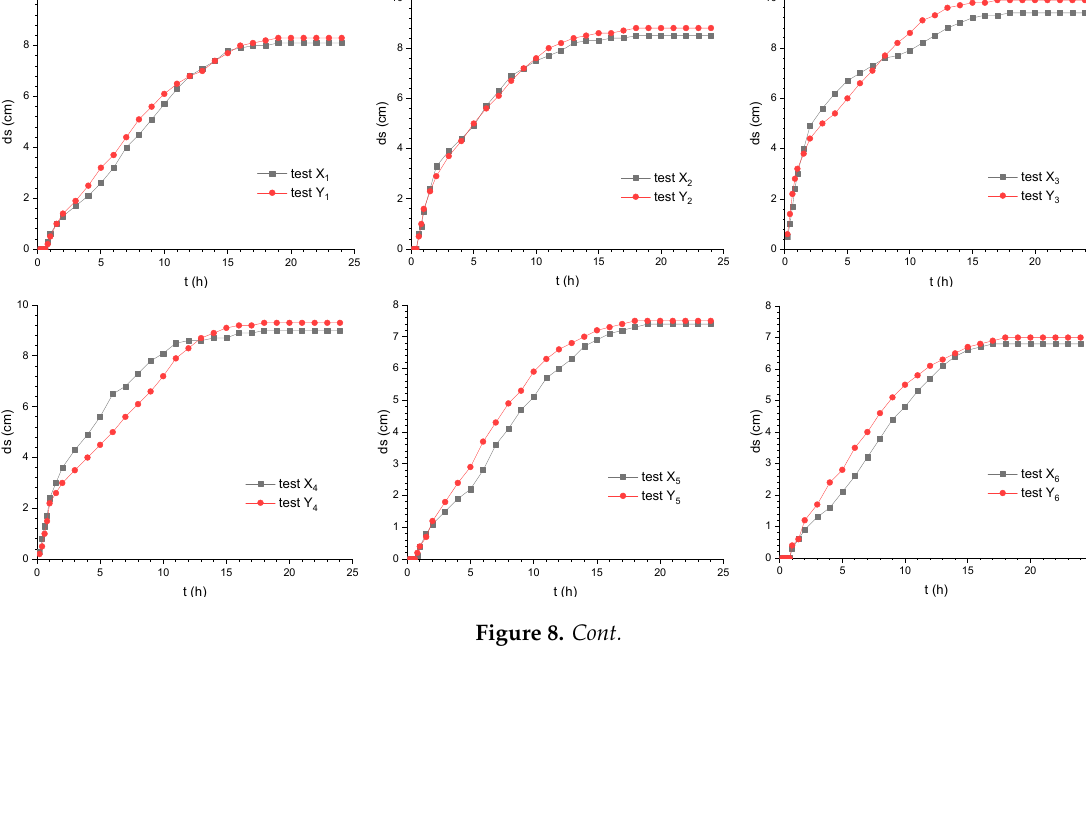
Figure 7. Comparison of the time variation of scour depths in tests of series X with pier modifications ( a ) (tests X 1 – X 11 ) with respect to the corresponding test with unprotected octagonal pier (test 9), ( D p = 5 cm, d 50 = 0.71 mm); ( b ) (tests X 12 – X 22 ) with respect to the corresponding test with unprotected octagonal pier (test 10), ( D p = 10 cm, d 50 = 0.71 mm). The comparison of the time variation of scour depths in experiments of series X ( d 50 = 0.71 mm) with the corresponding tests of series Y ( d 50 = 0.98 mm) is shown in Figures 8 and 9. The temporal variation of scour depths at pier diameters D p = 5 cm (tests X 1 – X 11 , Y 1 – Y 11 ) and 10 cm (tests X 12 – X 22 , Y 12 – Y 22 ) are presented in Figures 8 and 9, respectively. In these figures, the general trend of the evolution of scour depth at a pier with pier modifications is the same as that of the unprotected octagonal pier.